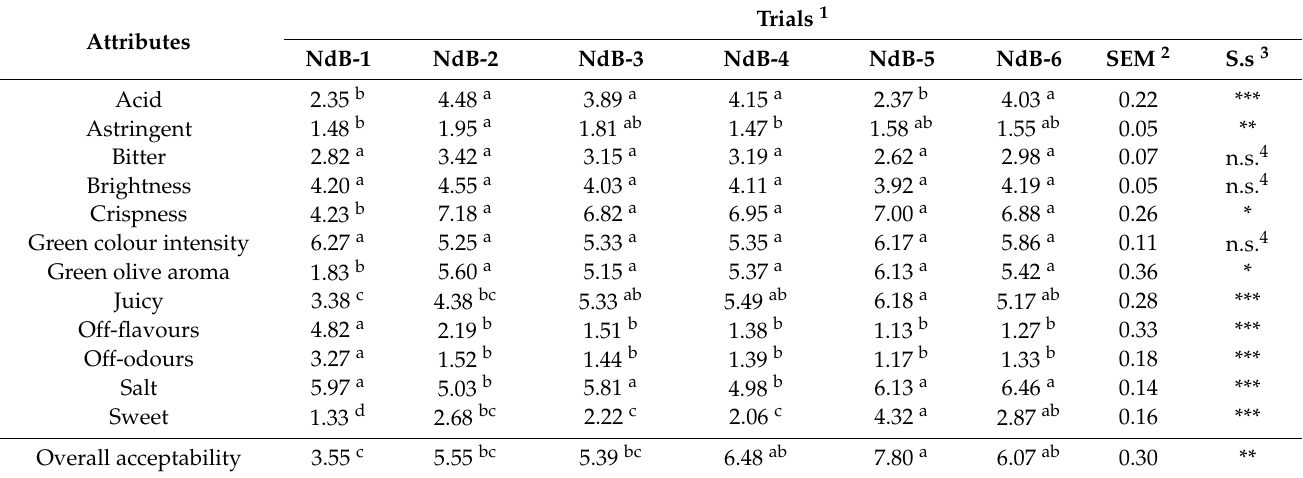
Data in the same line followed by the same letter are not significantly different according to Tukey’s test. p value: ***, p < 0.001; **, p < 0.01; *, p < 0.05. 1 Trial codes: NdB-1, spontaneous fermentation; NdB-2, L. pentosus OM13; NdB-3, L. pentosus OM13 + nutrient A; NdB-4, L. pentosus OM13 + nutrient B; NdB-5, L. pentosus OM13 + nutrient C; NdB-6, L. pentosus OM13 + nutrient D. 2 Standard error of the mean. 3 Statistical significance. 4 Not significant.